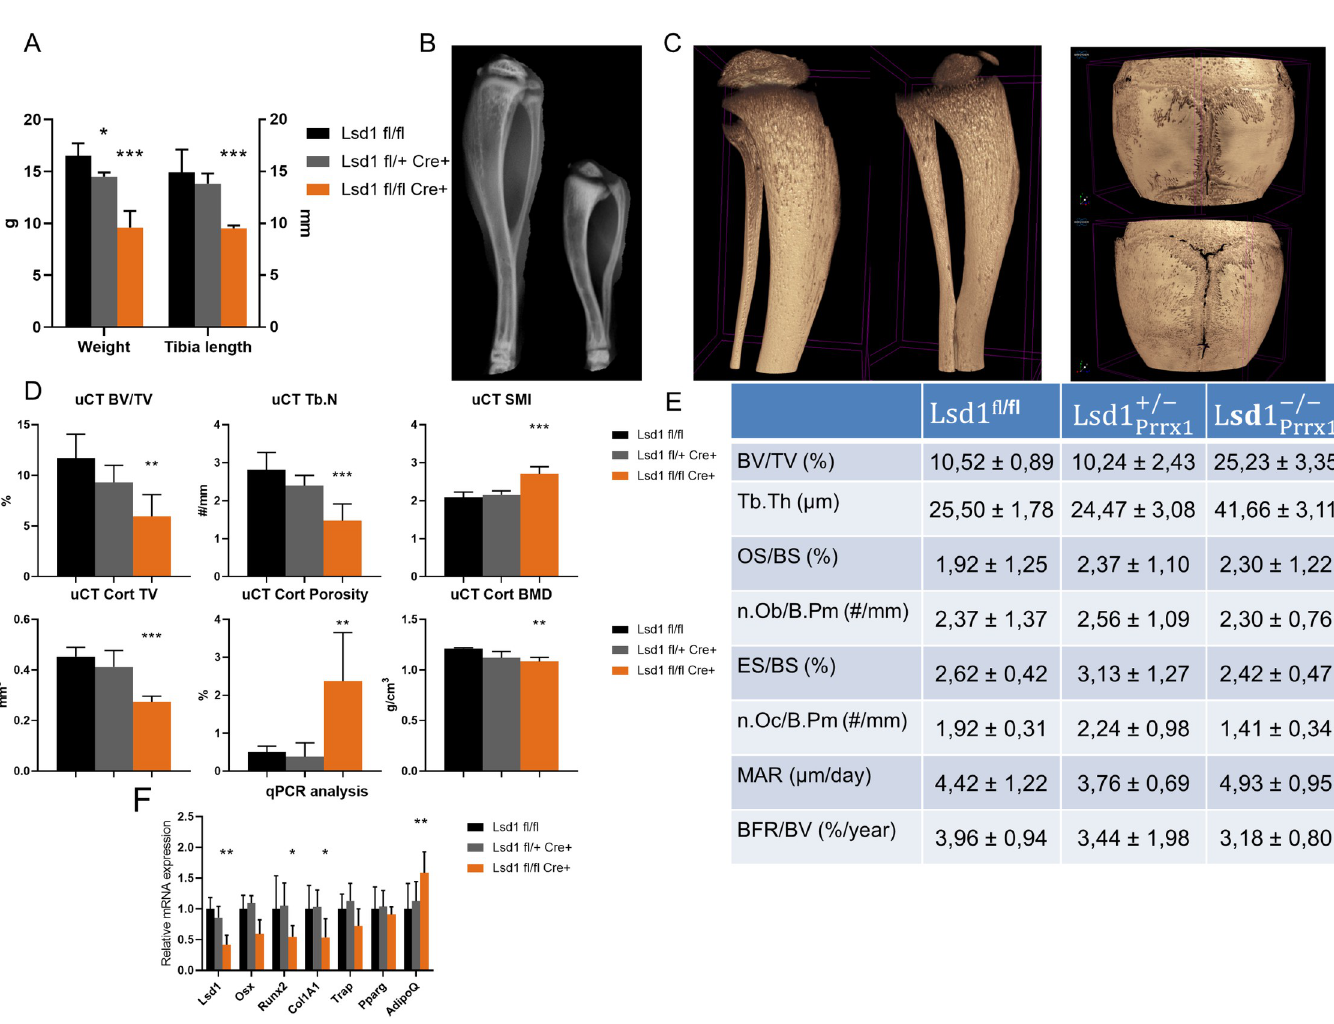
Fig 4. Loss of Lsd1 in long bone mesenchymal cells leads to impaired ossification and growth. (A) Lsd1 knockout mice have decreased body weight and length of tibia. (B) 2D X-ray data shows osteogenesis imperfecta-like phenotype with increased curvature, impaired secondary ossification and non-union of the fibula to the tibia in the Lsd1-cKO mice (right) compared to control (left). (C) Representative 3D models of μ CT data shows similar loss of secondary ossification site and unclosed calvarial sutures in the Lsd1-cKO mice (right, bottom) compared to the control mice (left, top). (D) 3D analysis of trabecular and cortical bone. (E) Histomorphometric analysis of trabecular bone. (F) RT-PCR analysis of RNA extracted from marrow-evacuated bone shows efficiency of Lsd1 knockout (~60%), decrease in osteoblast markers Osx , Runx2 and Col1A1 , no significant change of osteoblast marker Trap and adipocyte marker PPARgamma , and a significant increase of AdipoQ expression. A-E: n = 5-7/ group, F: n = 5/group. P-values for statistically significant differences are marked � P < 0.05, �� P < 0.01, ��� P < 0.001.